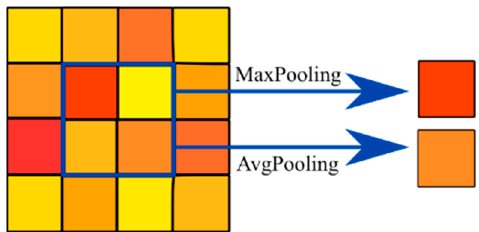
Figure 6. Graphic example of Max-pooling and Avg-pooling functions.